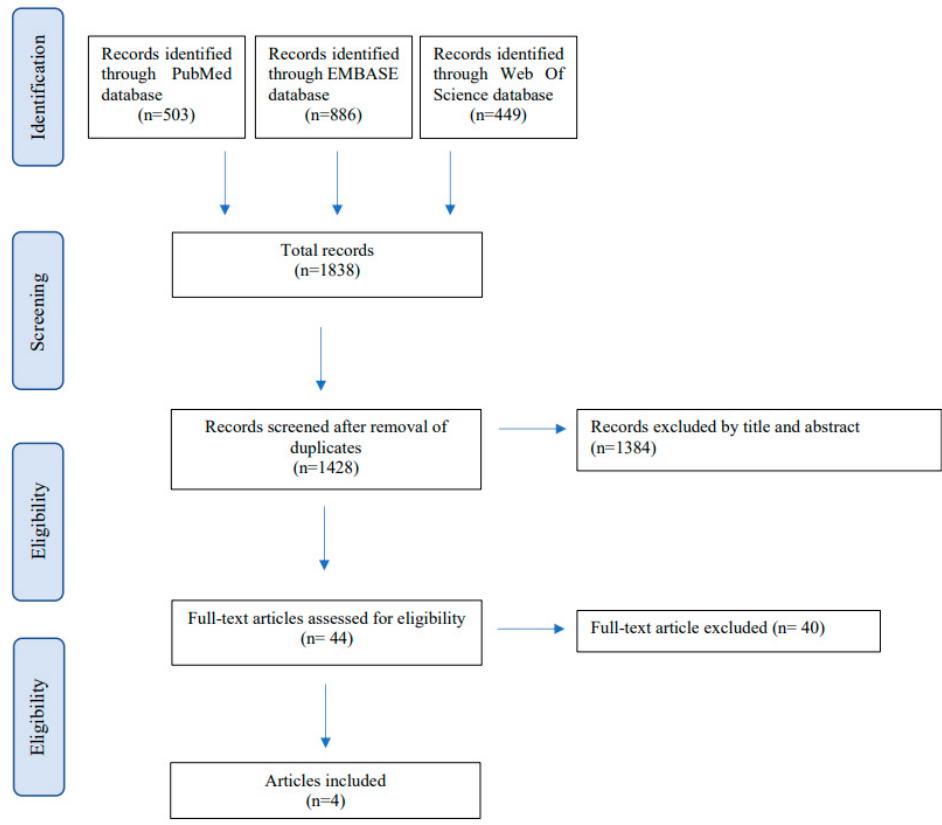
Figure 1. Paper selection according to the PRISMA statement [7].